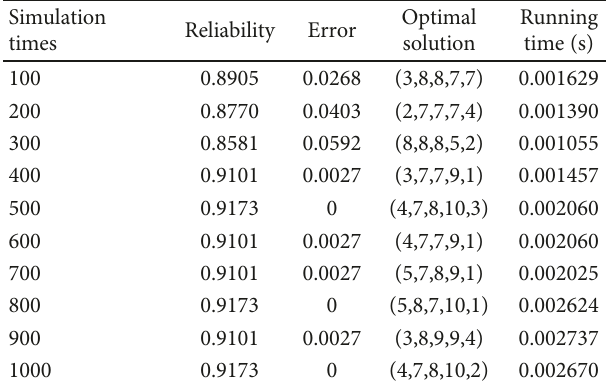
Table 2: Simulation results with a step size of 100 in the